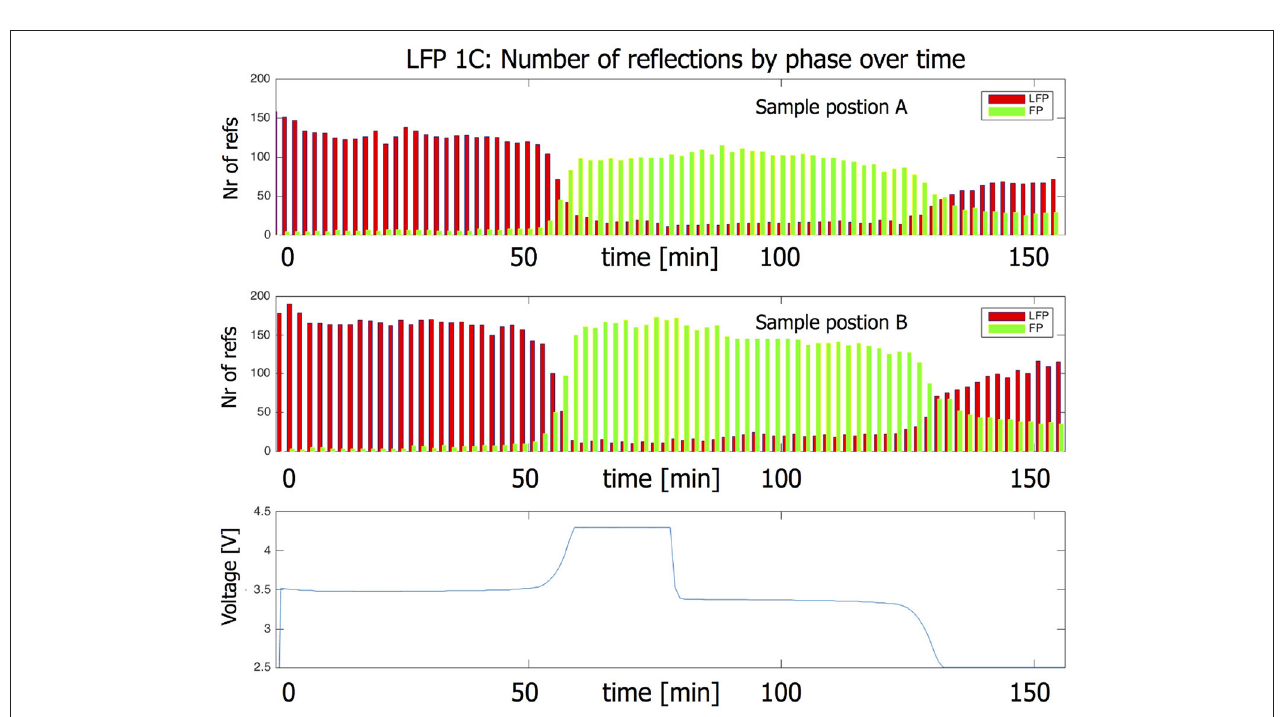
FIGURE 4 | Number of LFP and FP reflections of individual grains during a 1C charge/discharge